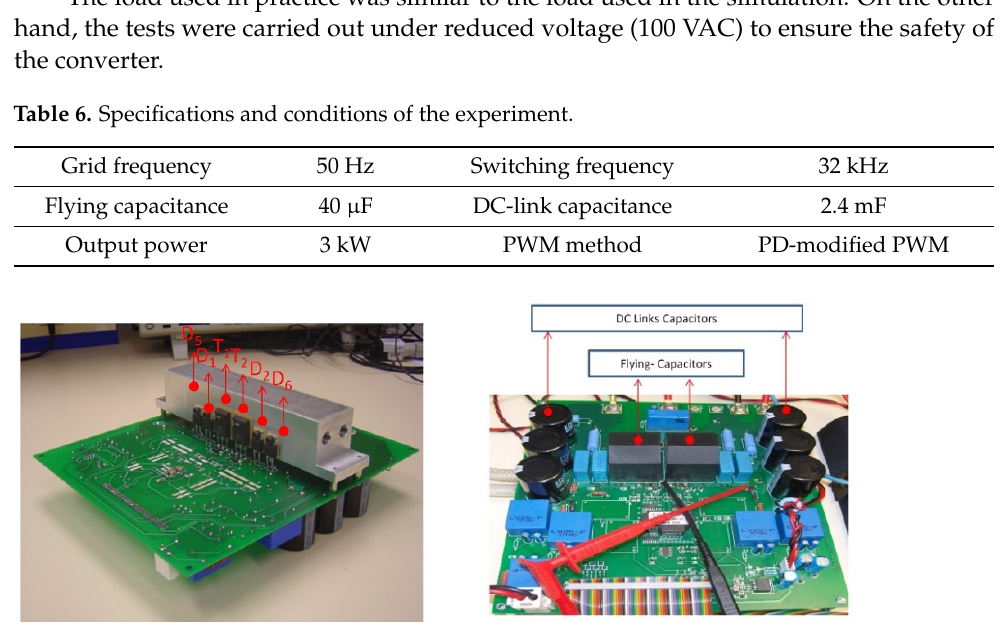
Figure 15. Theoretical results for three cases.